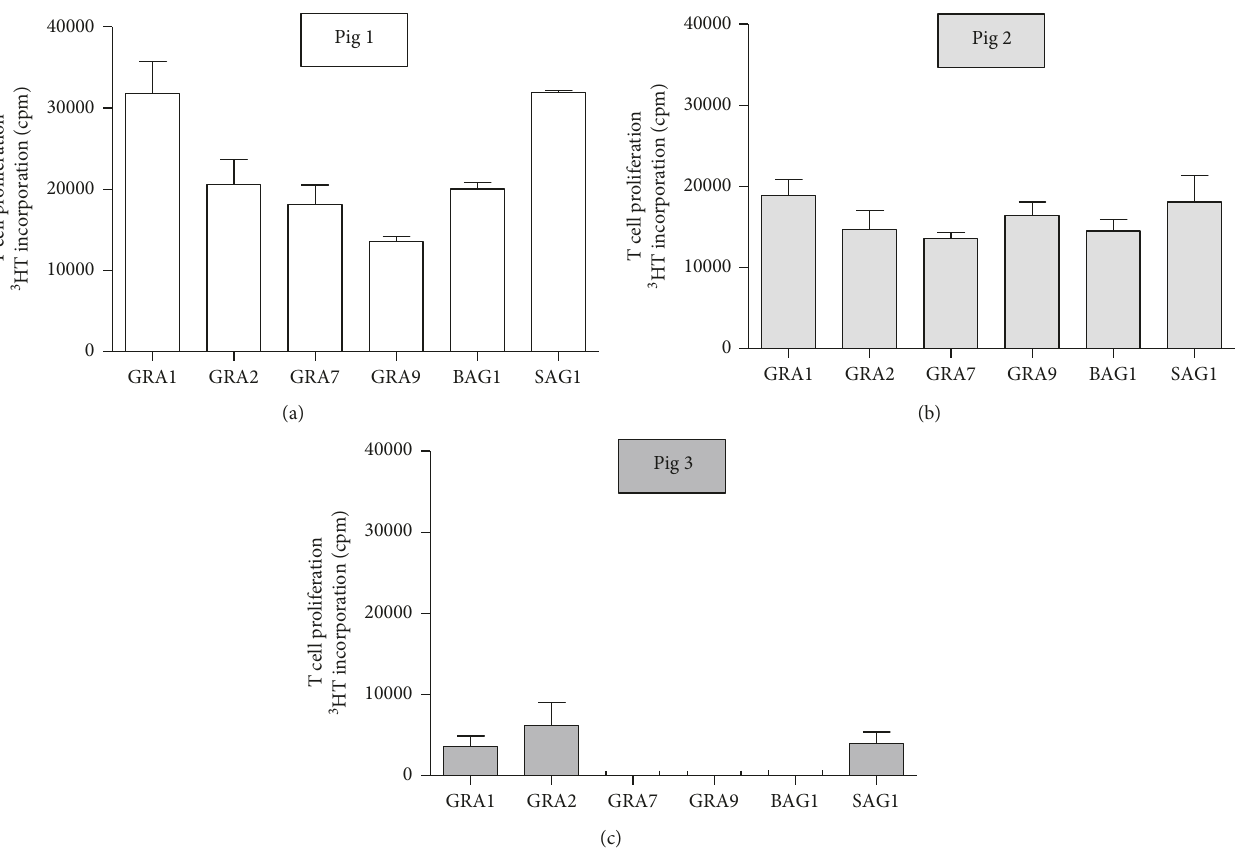
Figure 3: Di ff erential response of PBMC harvested from di ff erent animals (pigs 1 – 3) to recombinant T. gondii antigens. 1.5 × 10 5 PBMC harvested 7 dpi were stimulated with recombinant T. gondii antigens (1 μ g/ml). T cell proliferation was determined on day 5 after in vitro stimulation. Data are given as mean counts per minute (cpm).